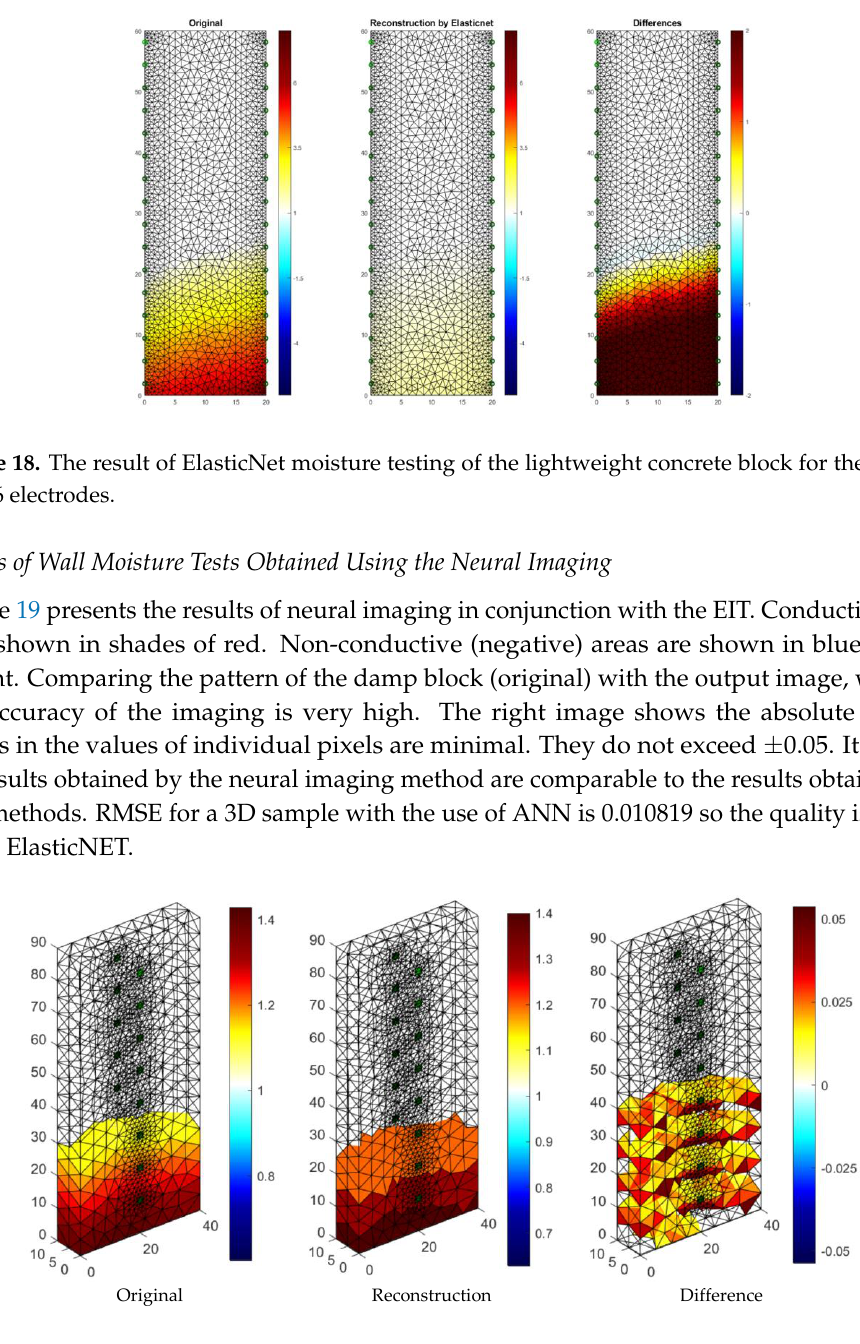
Figure 19. The result of Artificial Neural Network system (ANN) moisture testing of the lightweight concrete block for the case of 2 × 8 electrodes.